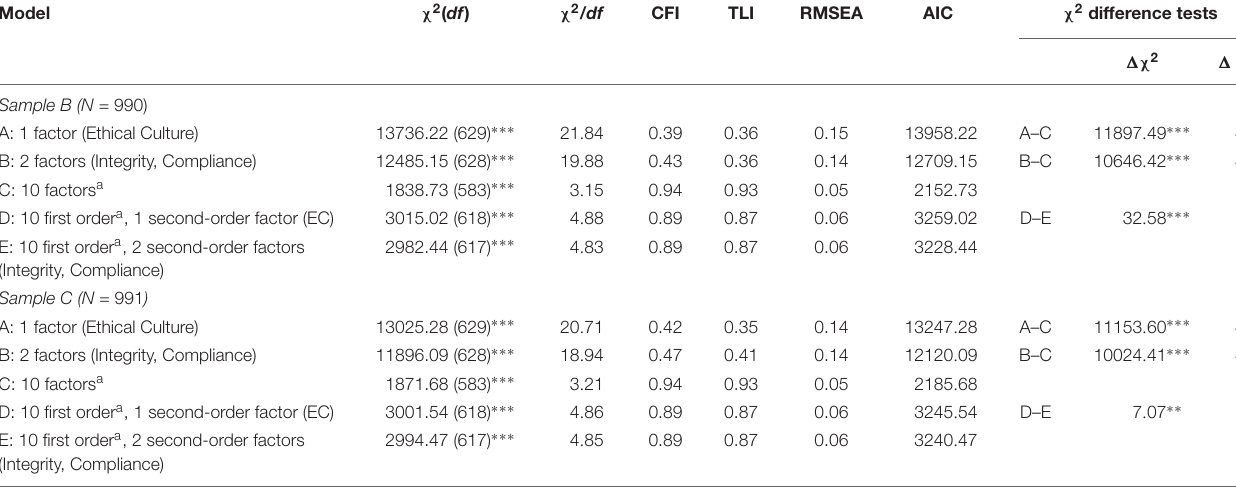
TABLE 4 | Goodness-of-Fit Indices of CFA models (Study 1b). Model